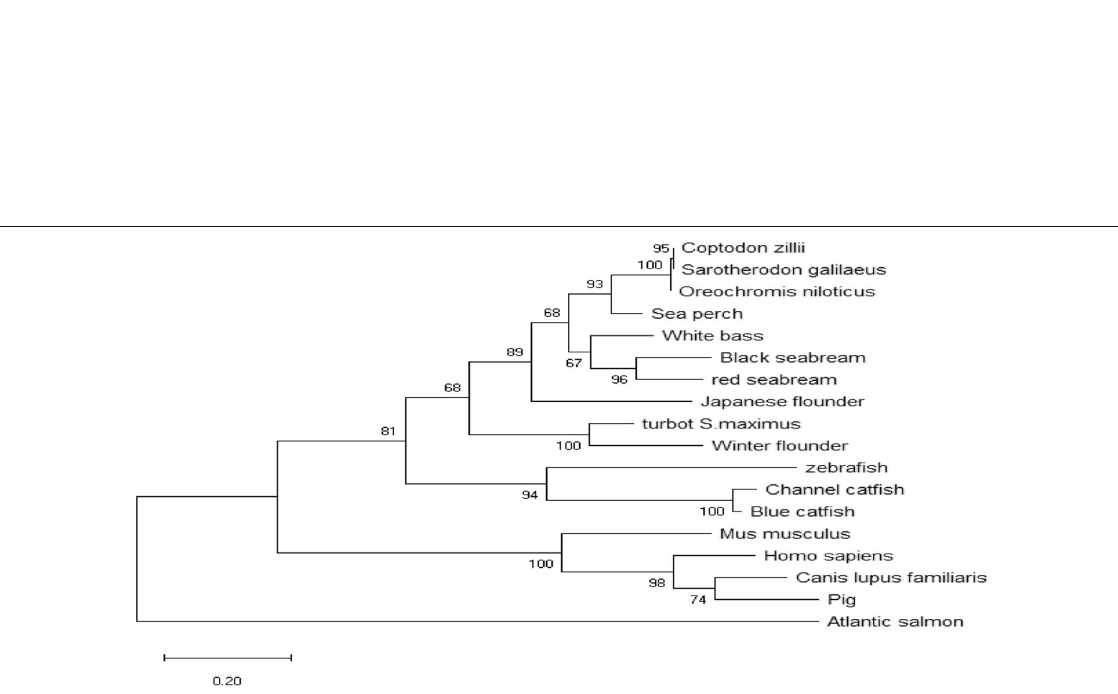
Fig. 5 Phylogenetic analysis of O. niloticus , T. zillii , and S. galilaeus hepcidin 1 gene and other species. Constructions are formed on the basis of the homology sequences calculated from the complete amino acid sequence of hepcidin genes. The tree is constructed using a neighbor-joining method. The scale is 0.20 which refers to percentage of